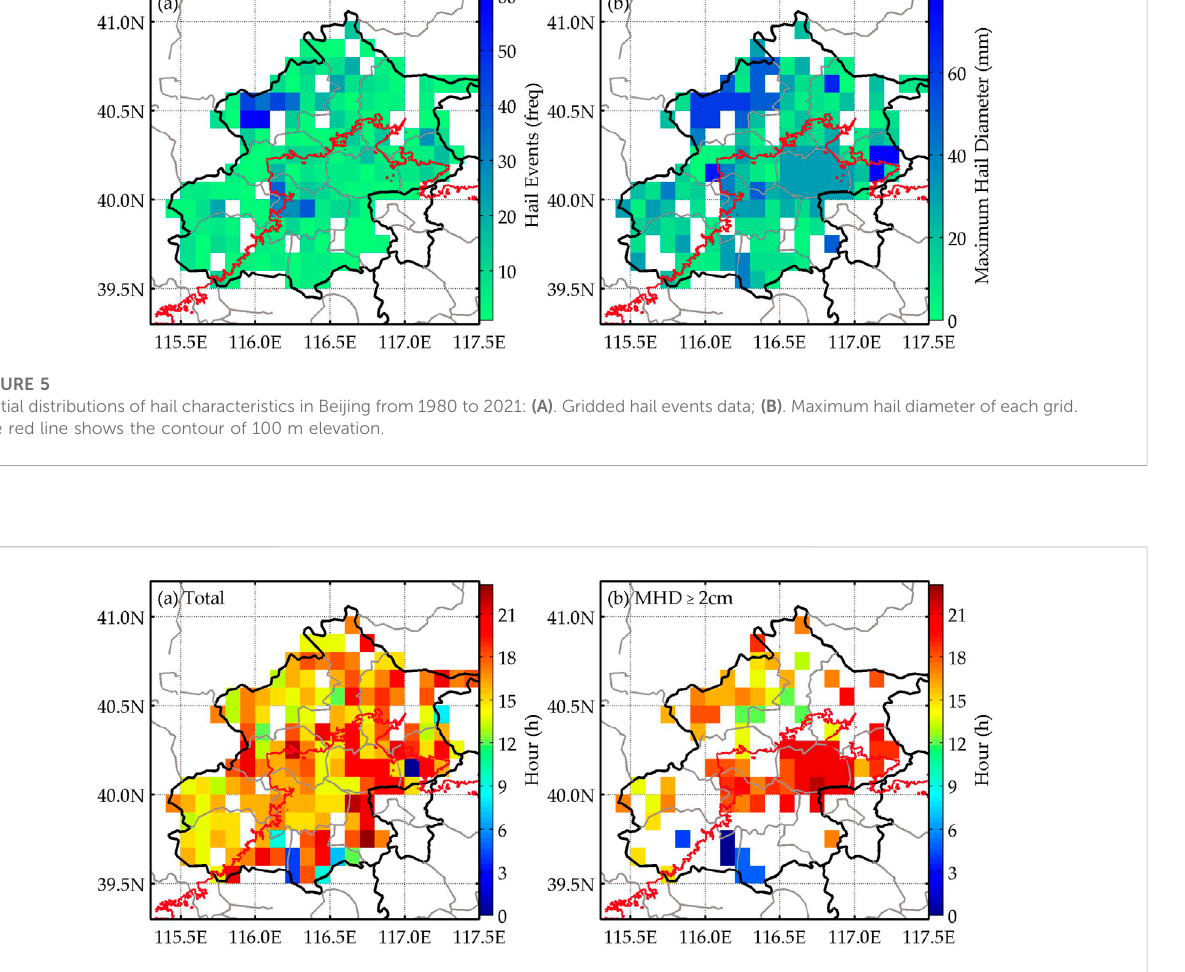
FIGURE 6 SpatialdistributionsofthehourwhenhailismostfrequentinBeijingfrom1980to2021: (A) .Totalhailevents; (B) .HaileventswithanMHDequal to or larger than 2